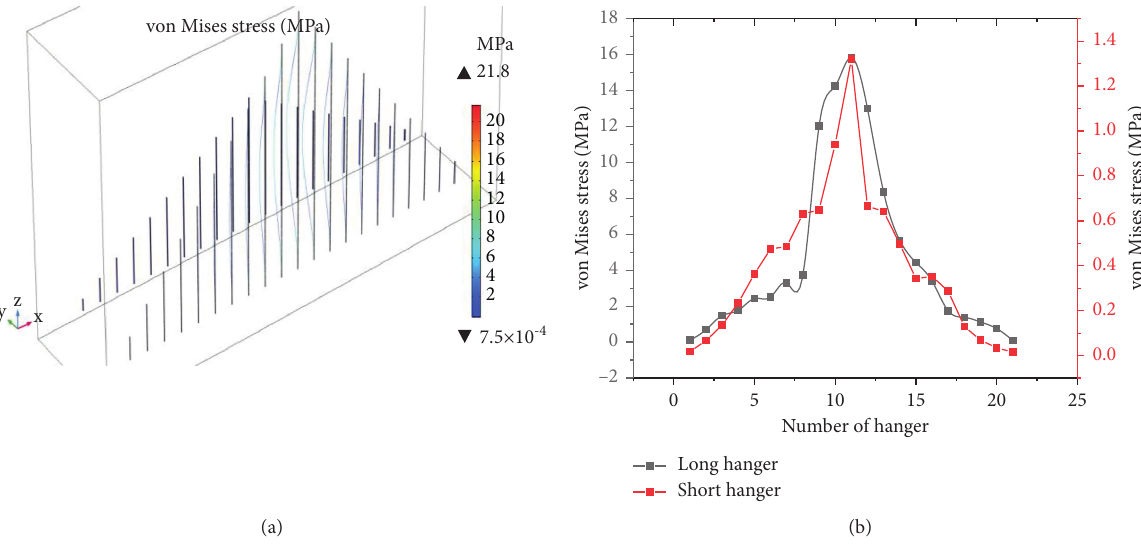
Figure 10: Stress distribution of hangers (wind direction � 90 ° ).